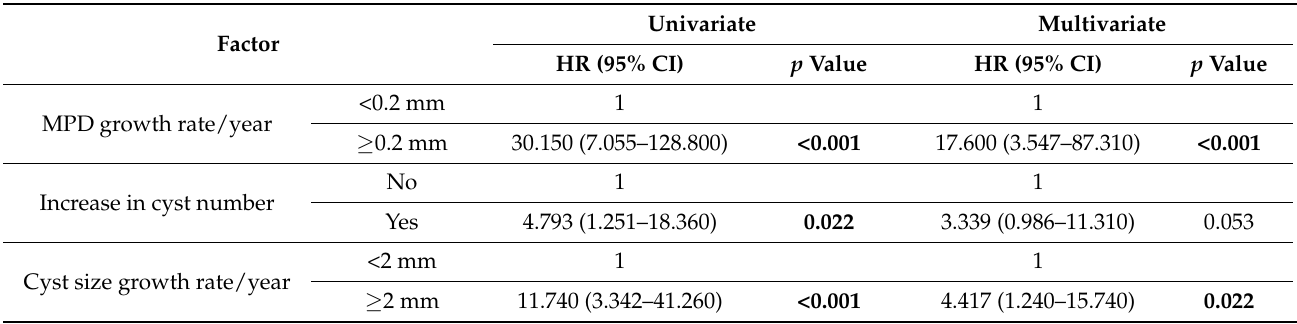
Table 4. Univariate and multivariate analyses of factors associated with changes in imaging findings during surveillance in relation to neoplastic